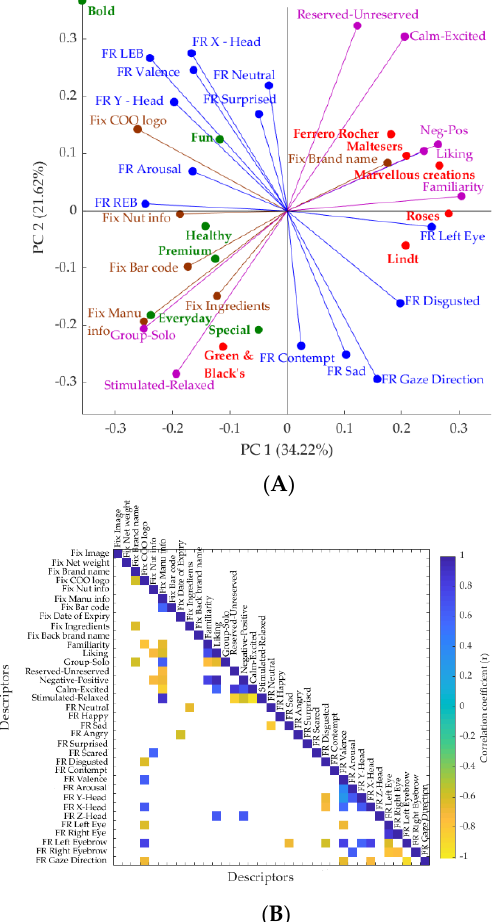
Figure 8. Results of ( A ) principal component analysis (PCA) and ( B ) correlation matrix of all self-reported and biometric responses against the chocolate packaging concepts. Red / circle: familiar packages, green / circle: novel packages, blue vector: fixations from eye tracking, brown vector: FR outputs, purple vector: conscious responses. The x-axis represents the principal component 1 (PC1) while the y-axis represents the principal component 2 (PC2) in the PCA. Abbreviations: AOI, area of interest; FR, FaceReader ™ ; Fix, number of fixations; COO, country of origin; Manu info, manufacturer’s information; Nut info, nutritional information; LEB, left eyebrow; REB, right eyebrow; Neg-Pos, negative to positive.